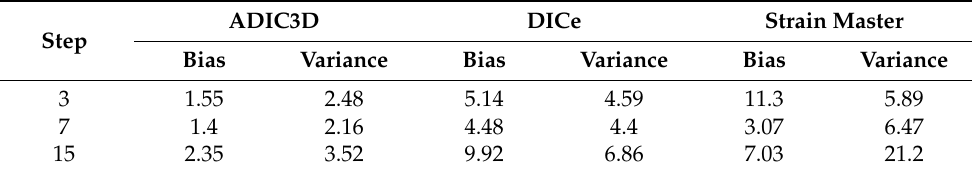
Table 16. Displacement error metrics for Sample 2 reported at × 10 − 3 mm.